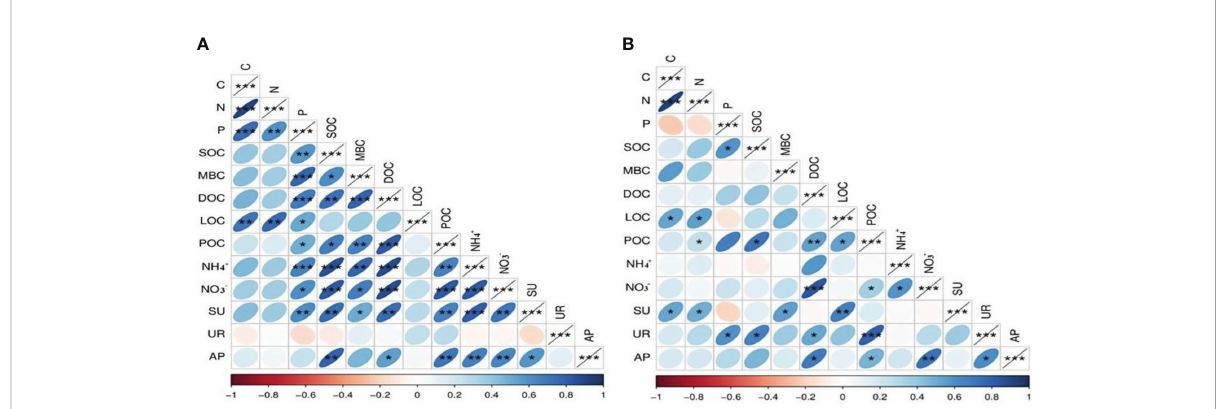
FIGURE 5 Pearson correlations between soil nutrient, SOC, SOC fractions, and soil enzyme activities under 0 – 10 cm depth (A) and 10 – 20 cm depth (B) . The symbols *, **, and *** indicate signi fi cant correlations at the 0.05, 0.01, and 0.001 levels, respectively. The bottom axis is the legend, on which correlation coef fi cient values are represented by different colors.